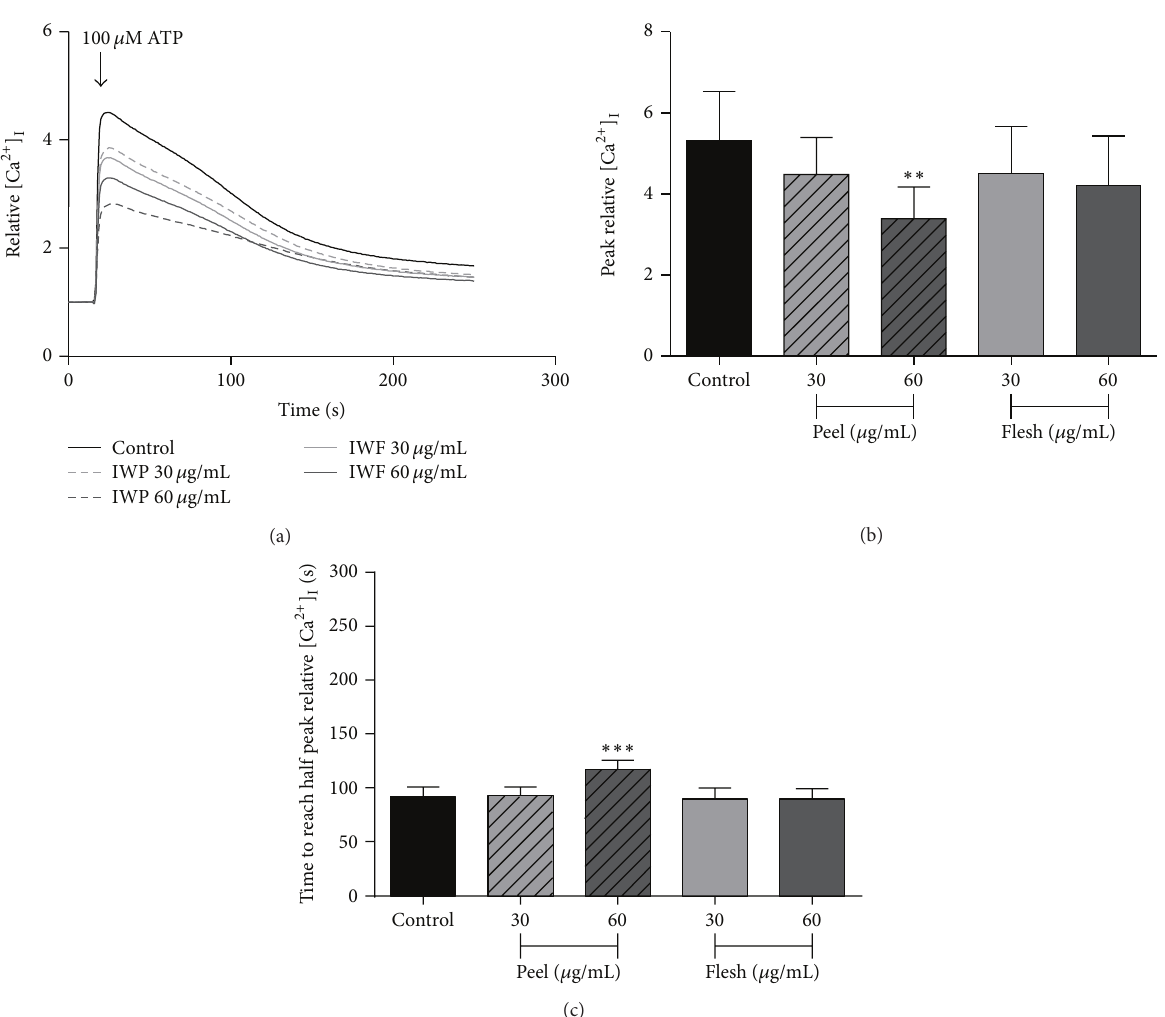
Figure 3: (a) Average relative [ Ca 2+ ] transients, (b) peak relative [ Ca 2+ ] response, and (c) time to reach half peak relative [ Ca 2+ ] I I cells treated with IW peel (P) and flesh (F) extracts for 96 h and stimulated with ATP (100 𝜇 M). Cells were loaded with Fluo-4 AM dye, relative [ Ca 2+ ] was measured using FLIPR TETRA and represented as response over baseline. Trace, mean ( 𝑛 = 9 ). Columns, means ( 𝑛 = 9 ) ± S.D. I ∗ 𝑃 ≤ 0.05 . ∗∗ 𝑃 ≤ 0.01 . ∗∗∗ 𝑃 ≤ 0.001